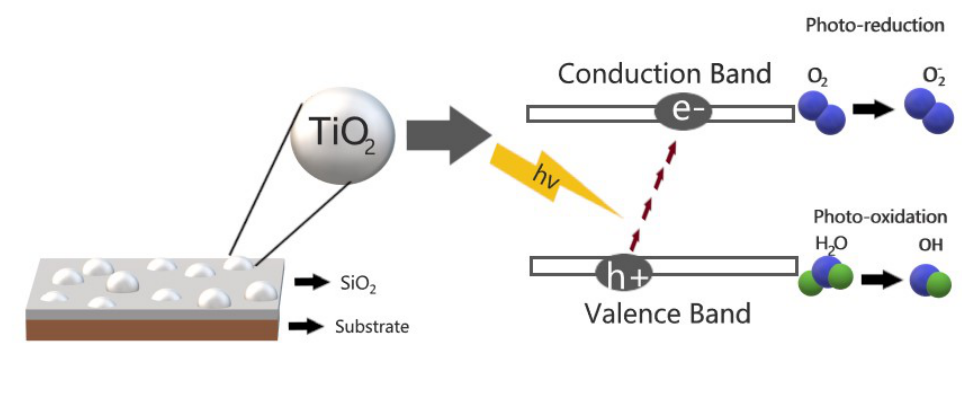
Figure 2. Photocatalytic activity of TiO 2 on SiO 2